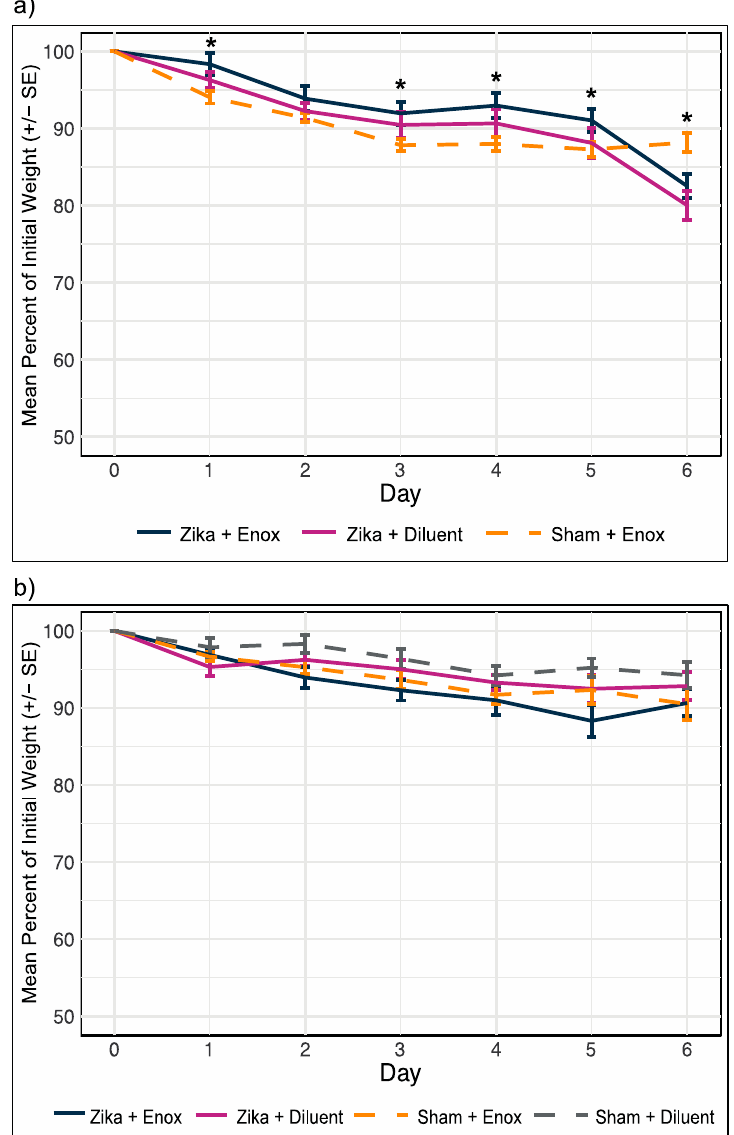
Figure 3. Mouse weight loss did not differ among treatments. ( a ) Daily percentage of initial weight for experiment 1 was the same for ZIKV infected mice treated with enoxacin (10 mg/kg and 15 mg/kg combined) or diluent and uninfected mice treated with enoxacin (10 mg/kg and 15 mg/kg combined) until day 6 p.i. when the infected mice, regardless of treatment, lost significantly more weight than the uninfected controls. ( b ) Percentage of initial weight for experiment 2 was not different among treatment groups. * at least one group is different at p < 0.05. Sample sizes in Table 2; full statistics in Table S2.